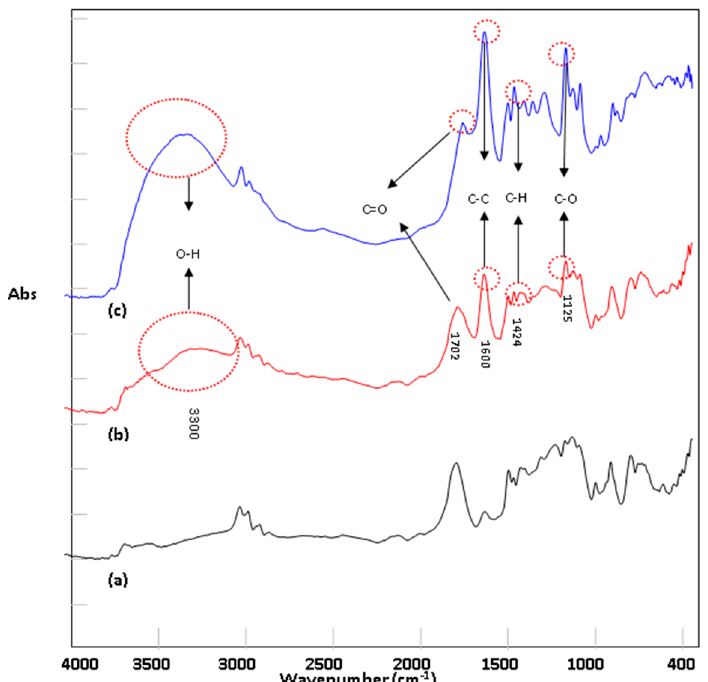
Figure 3. FTIR spectra of acetic acid plasma modified poly ( dl -lactide-co-glycolide)s (PLGAs) ( a ) untreated; ( b ) treated with AAP: 30 W, 10 min; ( c ) treated with AAP: 50 W, 10 min.